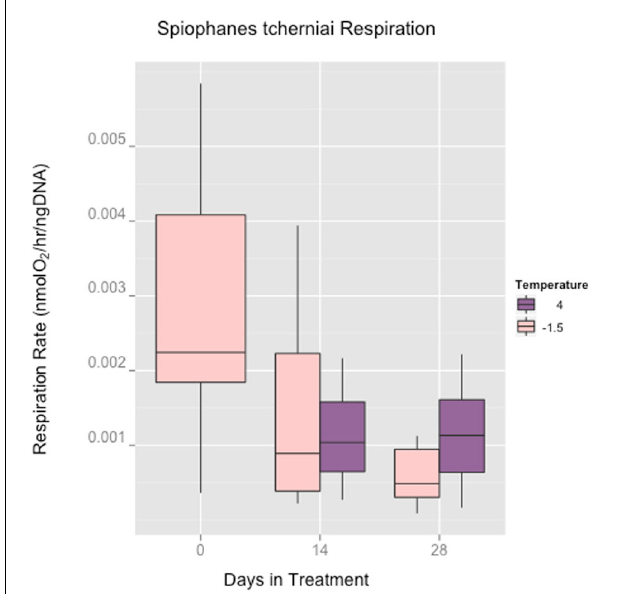
FIGURE 1 | Spiophanes tcherniai oxygen consumption rates normalized to DNA mass in maintained for 4 weeks at − 1.5C ◦ C and + 4 ◦